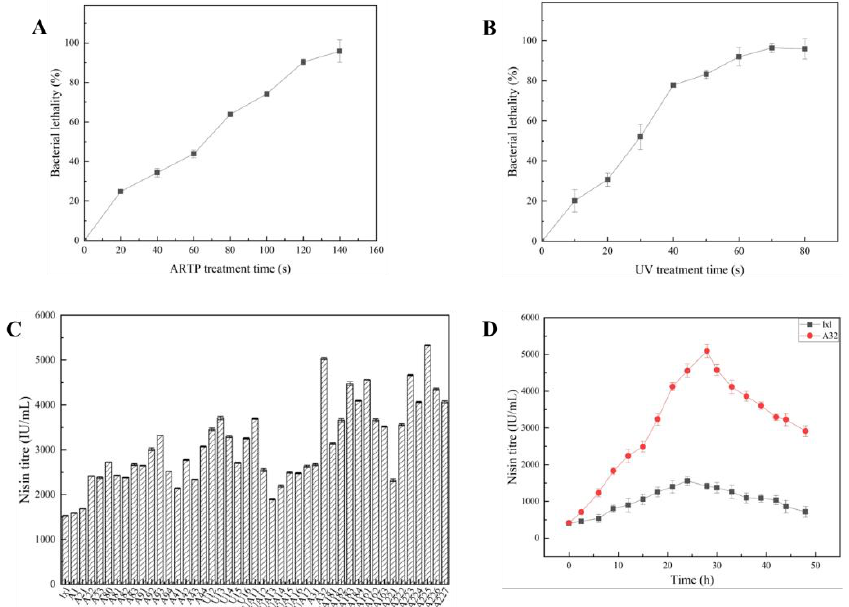
Figure 2. Mutagenesis preparation and results. ( A ) Lethality to L. lactis lxl of ARTP mutagenesis; ( B ) lethality to L. lactis lxl of UV mutagenesis; ( C ) mutagenic strain titre; ( D ) titre curves of L. lactis A32 and lxl with increasing fermentation times.